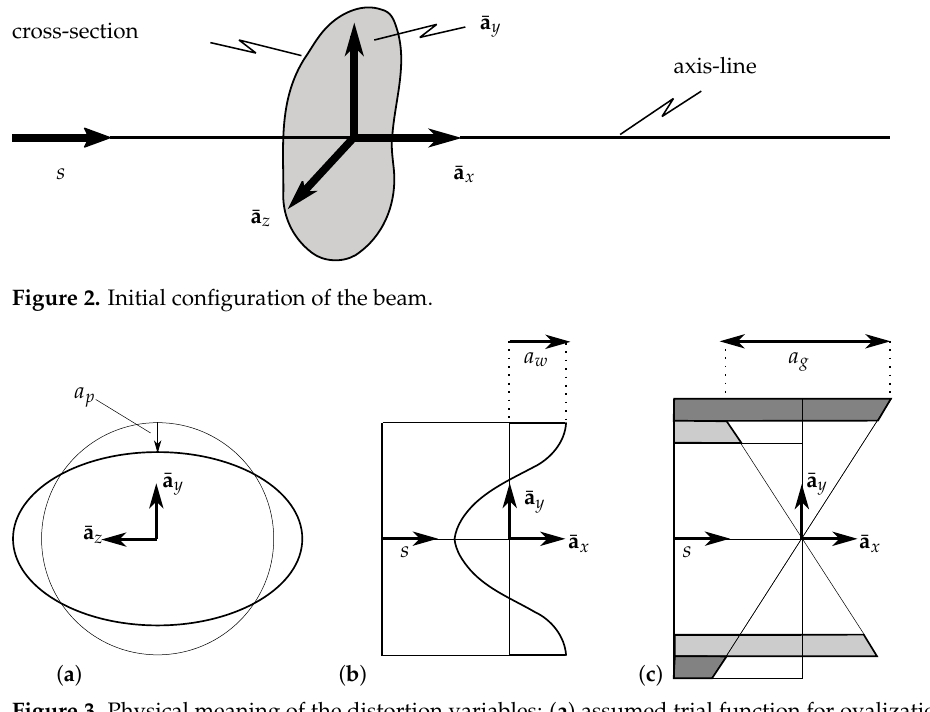
Figure 3. Physical meaning of the distortion variables: ( a ) assumed trial function for ovalization and amplitude a p ; ( b ) assumed trial function for warping and amplitude a w ; ( c ) assumed trial function for longitudinal sliding of the layers under opposite bending and amplitude a g